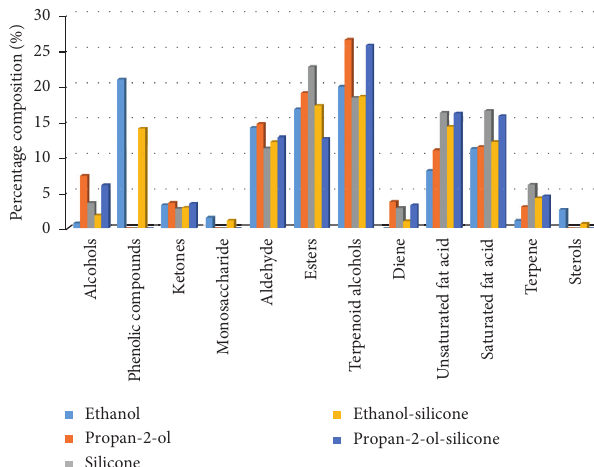
Figure 1: Component composition of the main classes of chemical compounds of the extract of apricot cake according to the results of chromatography-mass-spectral